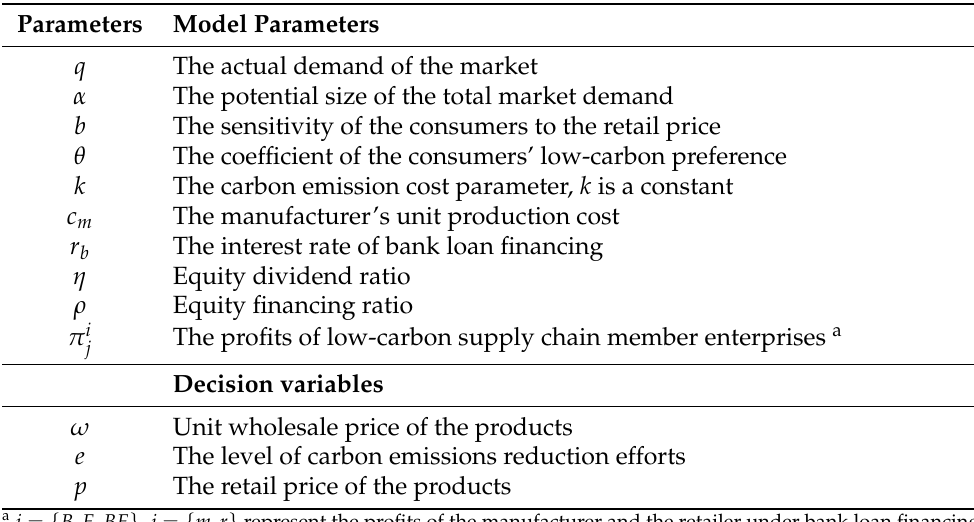
Table 1. Notations